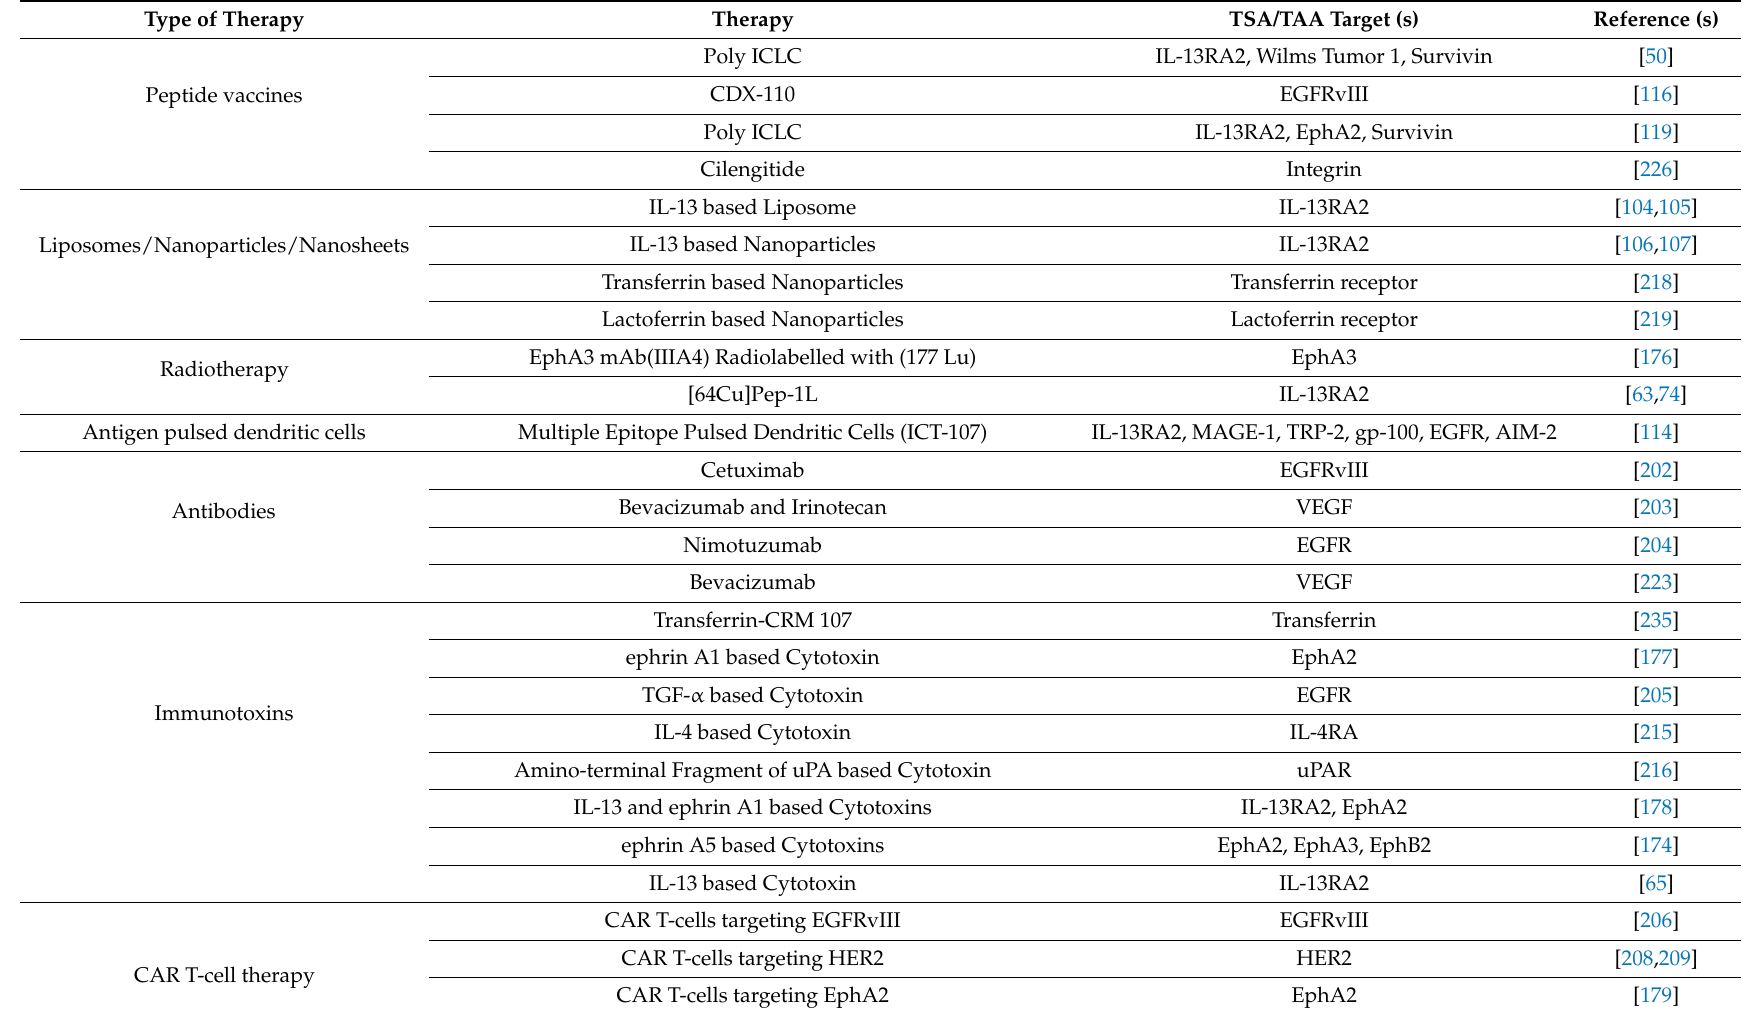
Table 1. An overview of the targeted therapies used to treat